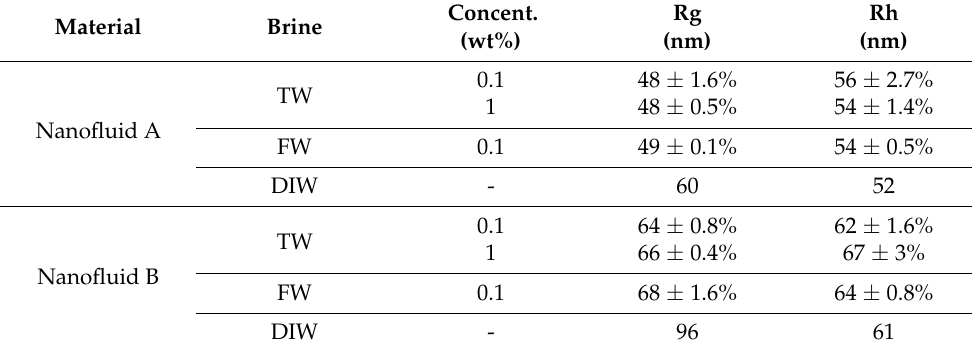
Table 9. Particle size measurements for different concentrations of nanofluids (NF) in two brines (formation water (FW) and test water (TW). Rg: Radius of gyration (R50; MALS), Rh: Hydrody- namic radius (DLS). The values in deionised water (DIW) have been provided by Evonik Resource Efficiency